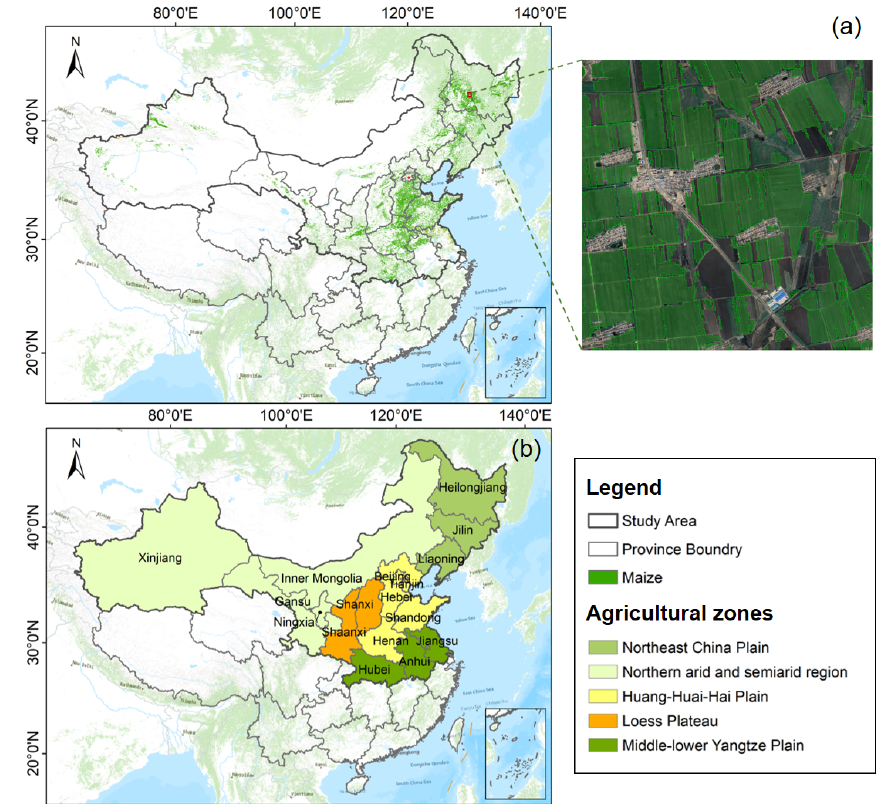
Figure 1. Distribution of maize within the study area (a) , which contains 17 provincial level administrative regions (b) . The green polygons, transformed from pixel-form classification results into vectors in (a) , indicate maize cover under a zoomed view in one specific site. Subplot (b) also shows the agricultural zones in China, and the data are from the Institute of Geographic Sciences and Natural Resources Research, Chinese Academy of Sciences. In addition, the base map of figures is from ESRI (https://www.arcgis.com/apps/mapviewer/index.html, last access: 13 August